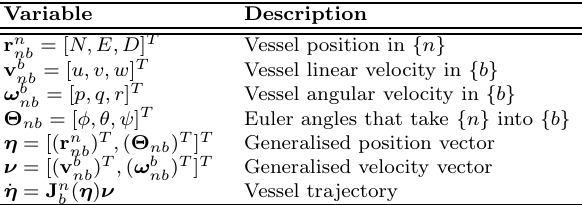
Table 2: Summary manoeuvring vector variables.